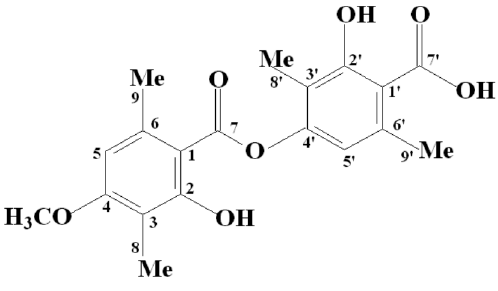
Figure 1. Structure of BAR.